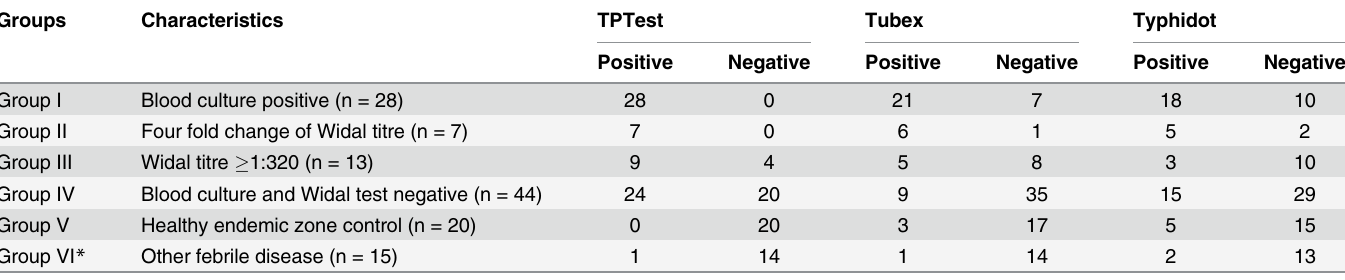
Table 2. Comparison of results among TPTest, Tubex, and Typhidot methods.